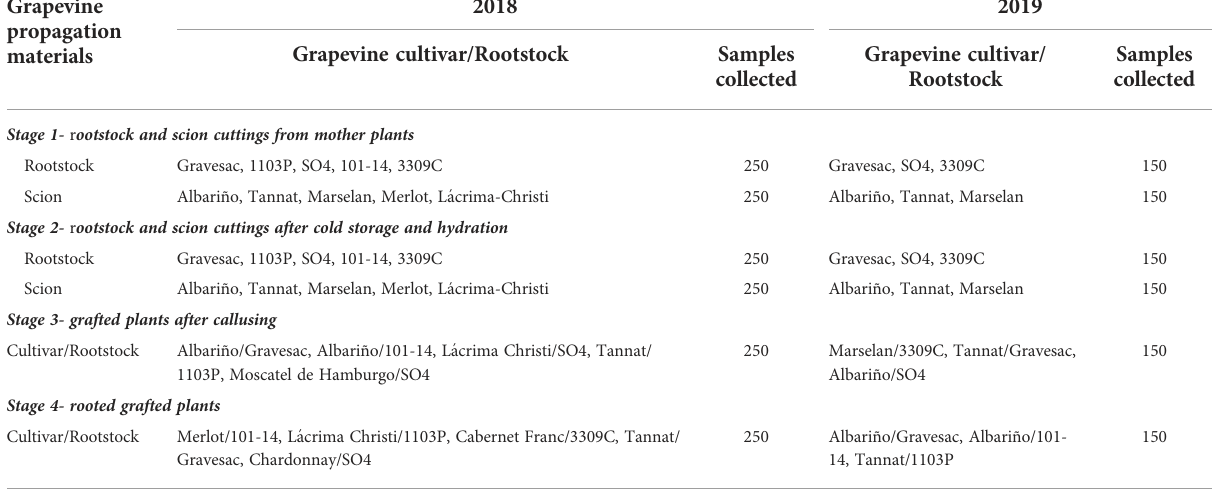
TABLE 1 Grapevine propagation materials sampled from four stages of the nursery process in 2018 and 2019: scion cultivars, rootstocks, and combination cultivar-rootstocks.